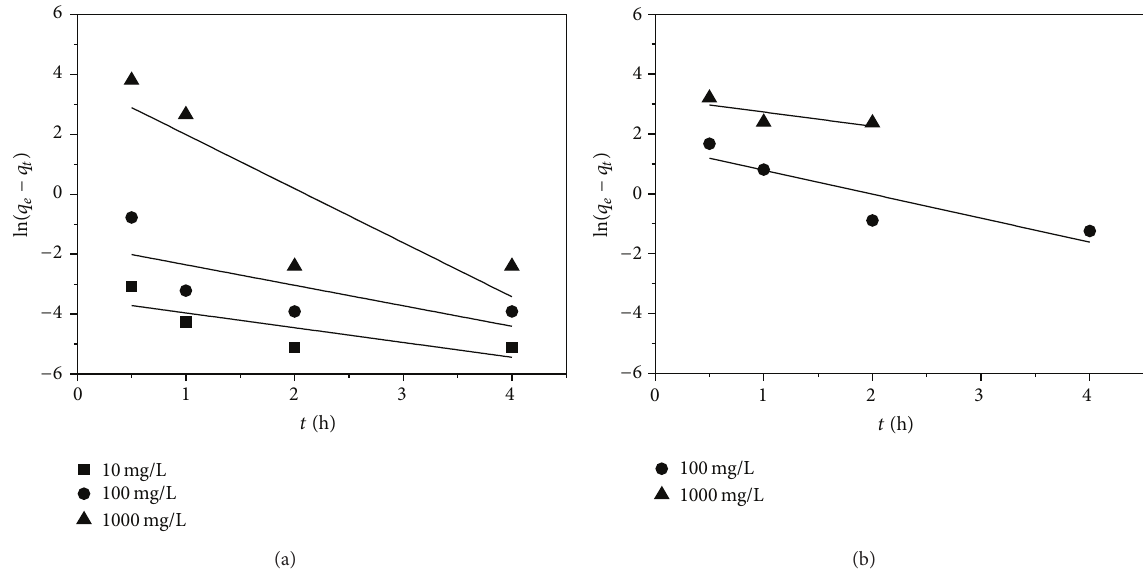
Figure 6: Pseudo-first-order kinetic model for adsorption of (a) Pb 2+ and (b) Cd 2+ on 30/70 HAp/chitosan hybrid fibers at initial metal ion concentration of 10mg/L (square), 100mg/L (circle), and 1000mg/L (triangle). Table 3: Pseudo-first-order kinetic parameters for adsorption of Pb 2+ and Cd 2+ on 30/70 HAp/chitosan hybrid fiber. Metal ions